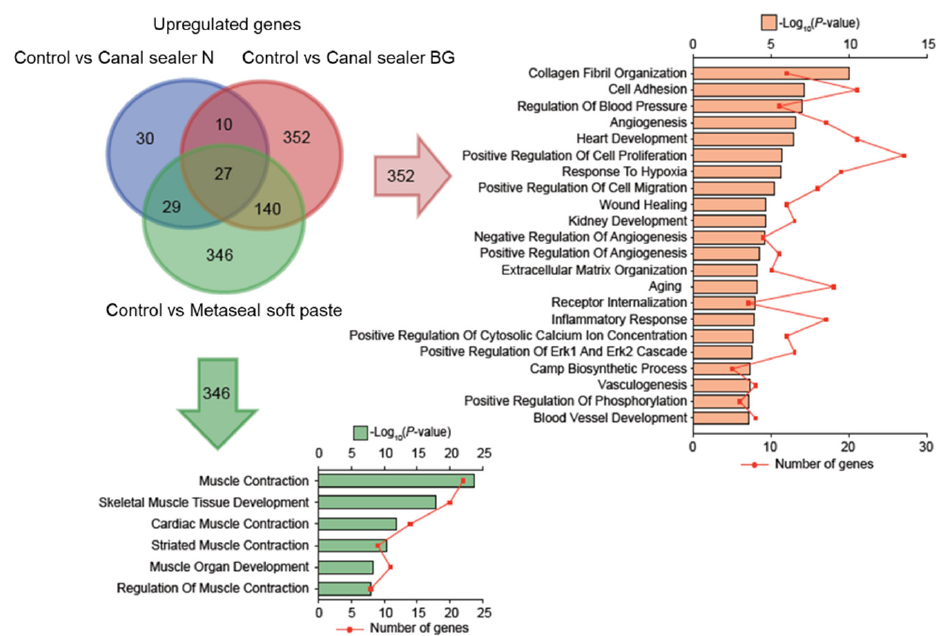
Figure 6. Unique GO terms of differentially upregulated genes in the Canal Sealer BG or Metaseal soft paste groups. The three-way Venn diagram illustrates the overlapping upregulated genes among groups. The top 22 unique GO terms in the Canal Sealer BG group are listed in red. The top six unique GO terms in the Metaseal soft paste group are listed in green.